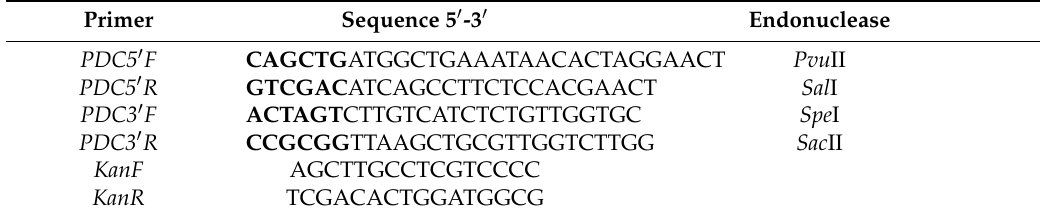
Table 2. Primers used in this study. Sequences of restriction enzymes are highlighted in bold.